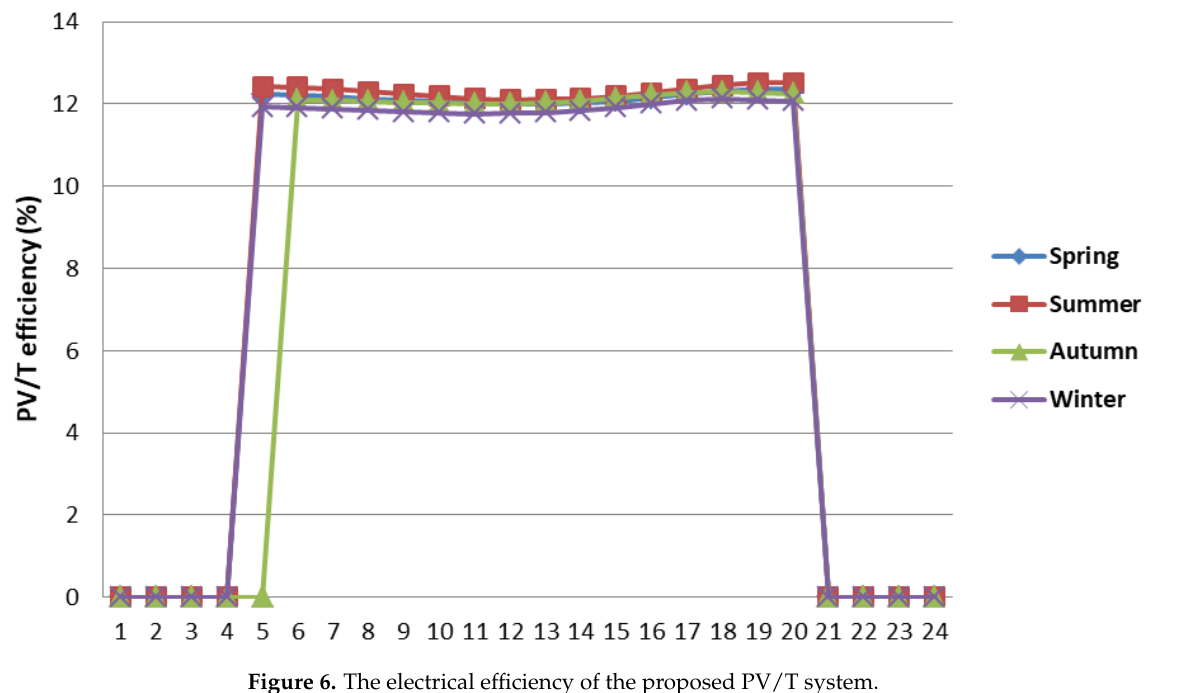
Figure 6. The electrical efficiency of the proposed PV/T system. Both energy and exergy efficiencies increased as the ambient temperature increased, as depicted in Figure 7. The energy efficiency rose by approximately 2% as the ambient temperature increased from − 10 °C to 30 °C. The exergy efficiency was increased by more than 2% by the same change in the ambient temperature.